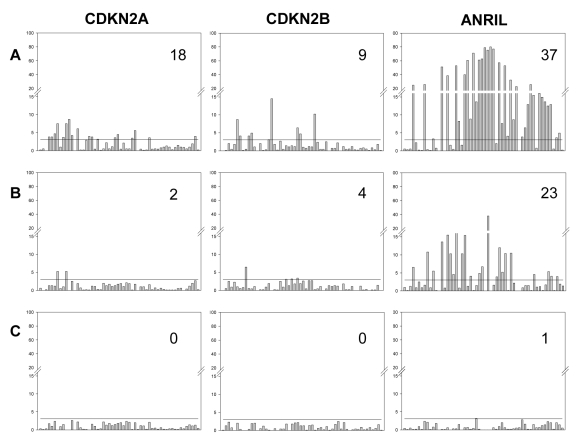
Effect of sequential adjustment for most highly associated SNPs.Bars represent the significance of association (−log10P) for each SNP. (A) Unadjusted. (B) Adjusted for the most highly associated SNP for each gene (CDKN2A rs7036656, CDKN2B rs3218018, ANRIL rs564398). (C) Adjusted for the two most highly associated SNPs for each gene (CDKN2A rs7036656 and rs36228834, CDKN2B rs3218018 and rs3814960, ANRIL rs564398 and rs10965215). Values in the top right corner are the number of significantly associated SNPs after each round of adjustment, following correction for multiple testing. The horizontal black line on each graph represents the significance threshold after adjustment for multiple testing (family wise error rate of 0.05 corresponding to −log10P = 3.05).